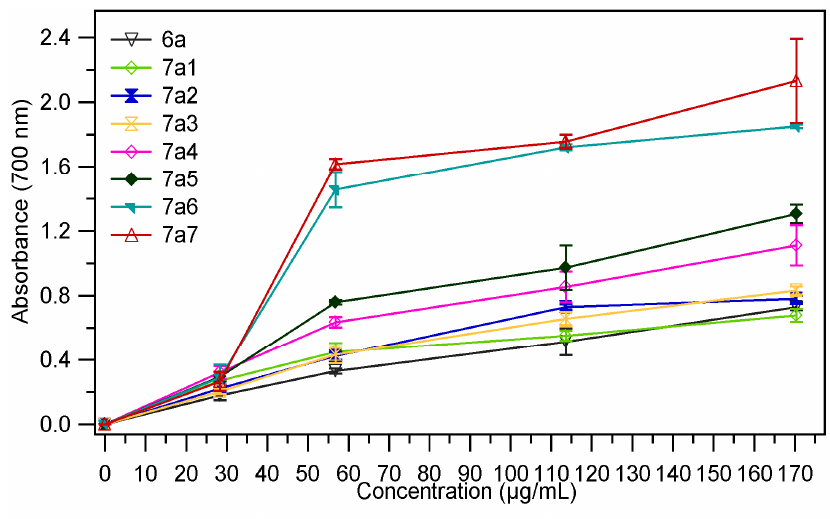
in ref. to 6a 1–7